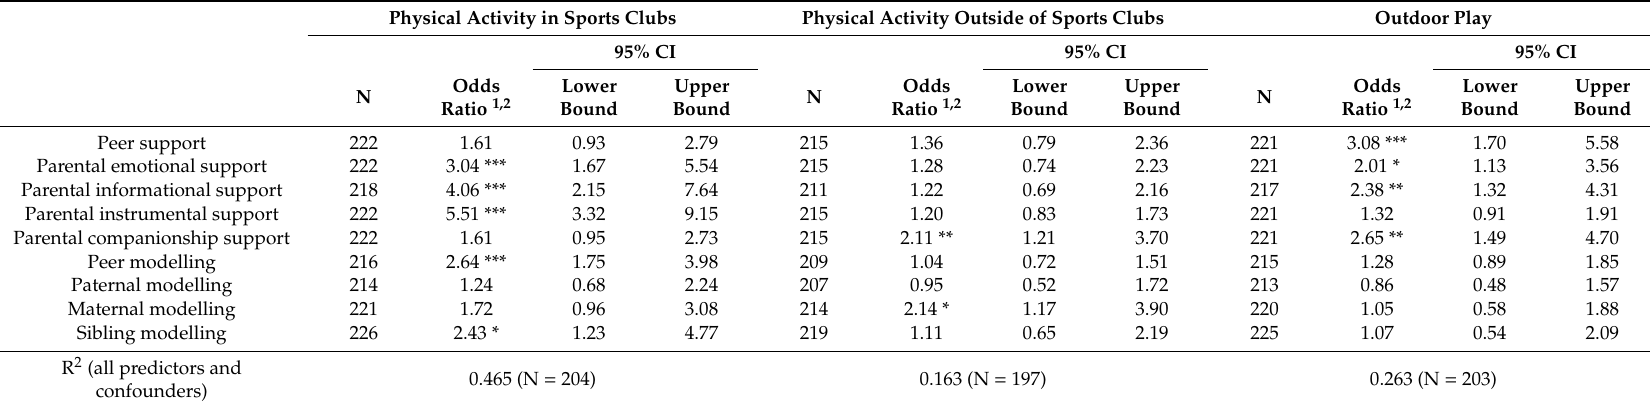
Table 4. Results of the logistic regression analysis of social support and physical activity in di ff erent domains in girls aged 4–6. Physical Activity in Sports Clubs Physical Activity Outside of Sports